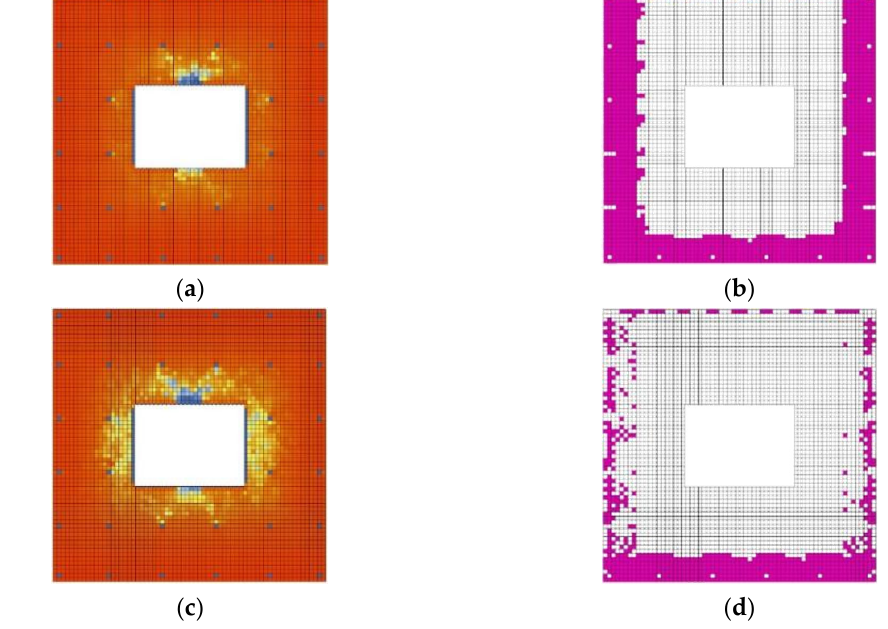
Figure 16. Lighting simulation result with or without expanded metal mesh (WWR= 80%). ( a ) Case 1: sDA = 99%; ( b ) Case 1: ASE = 39.0%; ( c ) Case 2: sDA = 96%; ( d ) Case 2: ASE = 18.9%.